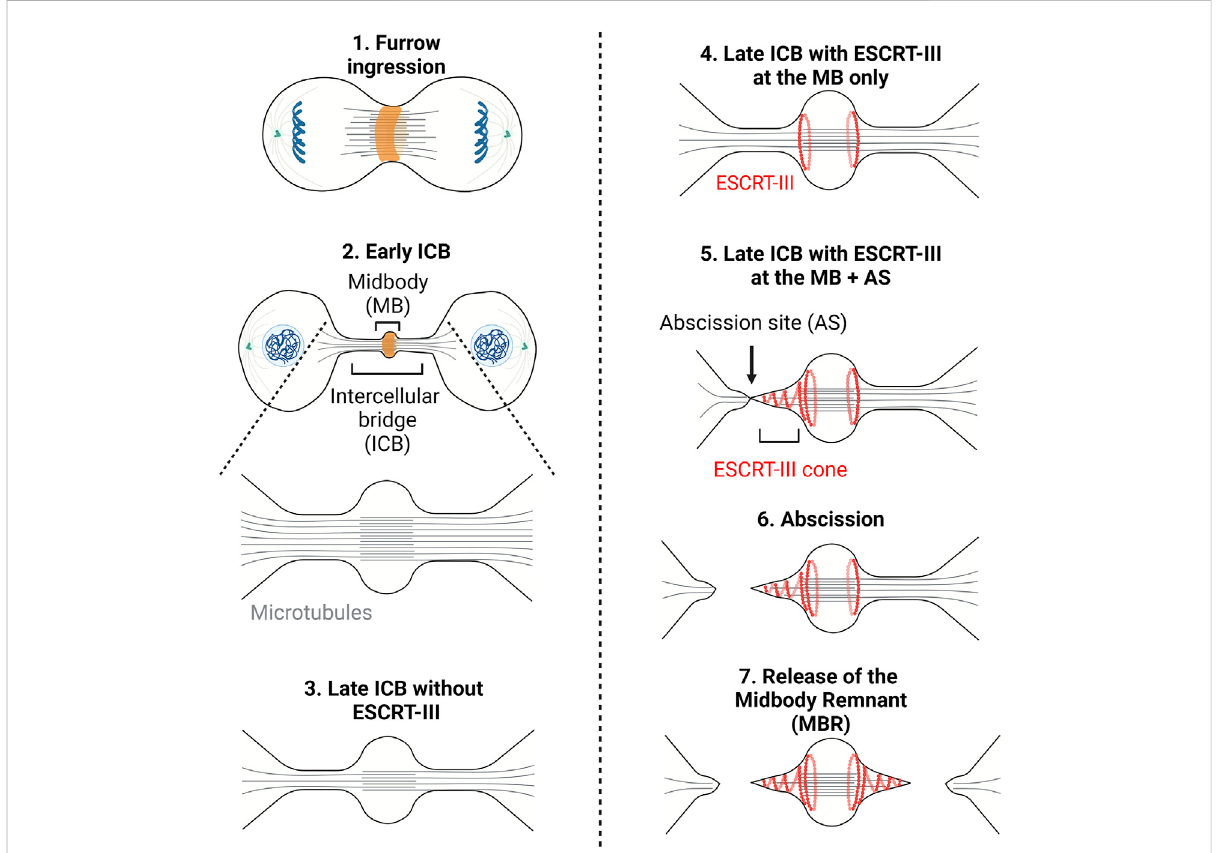
FIGURE 1 – Cytokinesis: A multi-step process. Step1 - Contraction of an actomyosin ring (orange) during furrow ingression. Step2 - Formation of the intercellular bridge (ICB) and midbody containing antiparallel microtubules (grey lines). Step3 - Thinning of the ICB. Step4 - Recruitment of the ESCRT-IIItothemidbody(MB).Step5-PolymerizationofESCRT-III(redcurves)ononesideofthemidbodyandseveringofthemicrotubules.Step6/ 7 — Scission of the ICB membrane (abscission) and release of the midbody remnant (Step7). Adapted from (Andrade et al.,